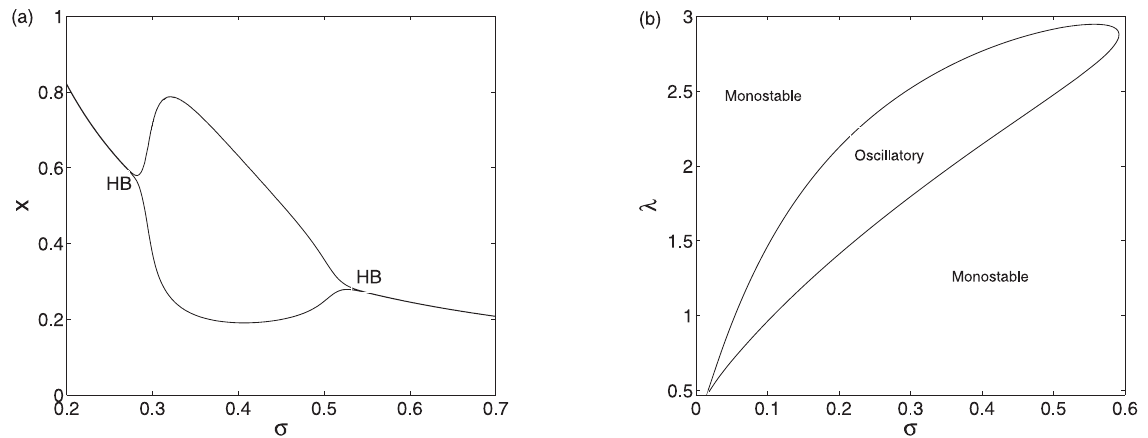
Figure 3. Bifurcation diagrams of model II. (a) The bifurcation diagram of model II with s as a control parameter. (b) The codimension two bifurcation diagram of model II with s and l as control parameters. Other parameter values are l ~ 0 : 6 , d ~ 0 : 5 , c ~ 0 : 2 , a ~ 2 , m ~ 0 : 5 , b ~ 0 : 2 , and